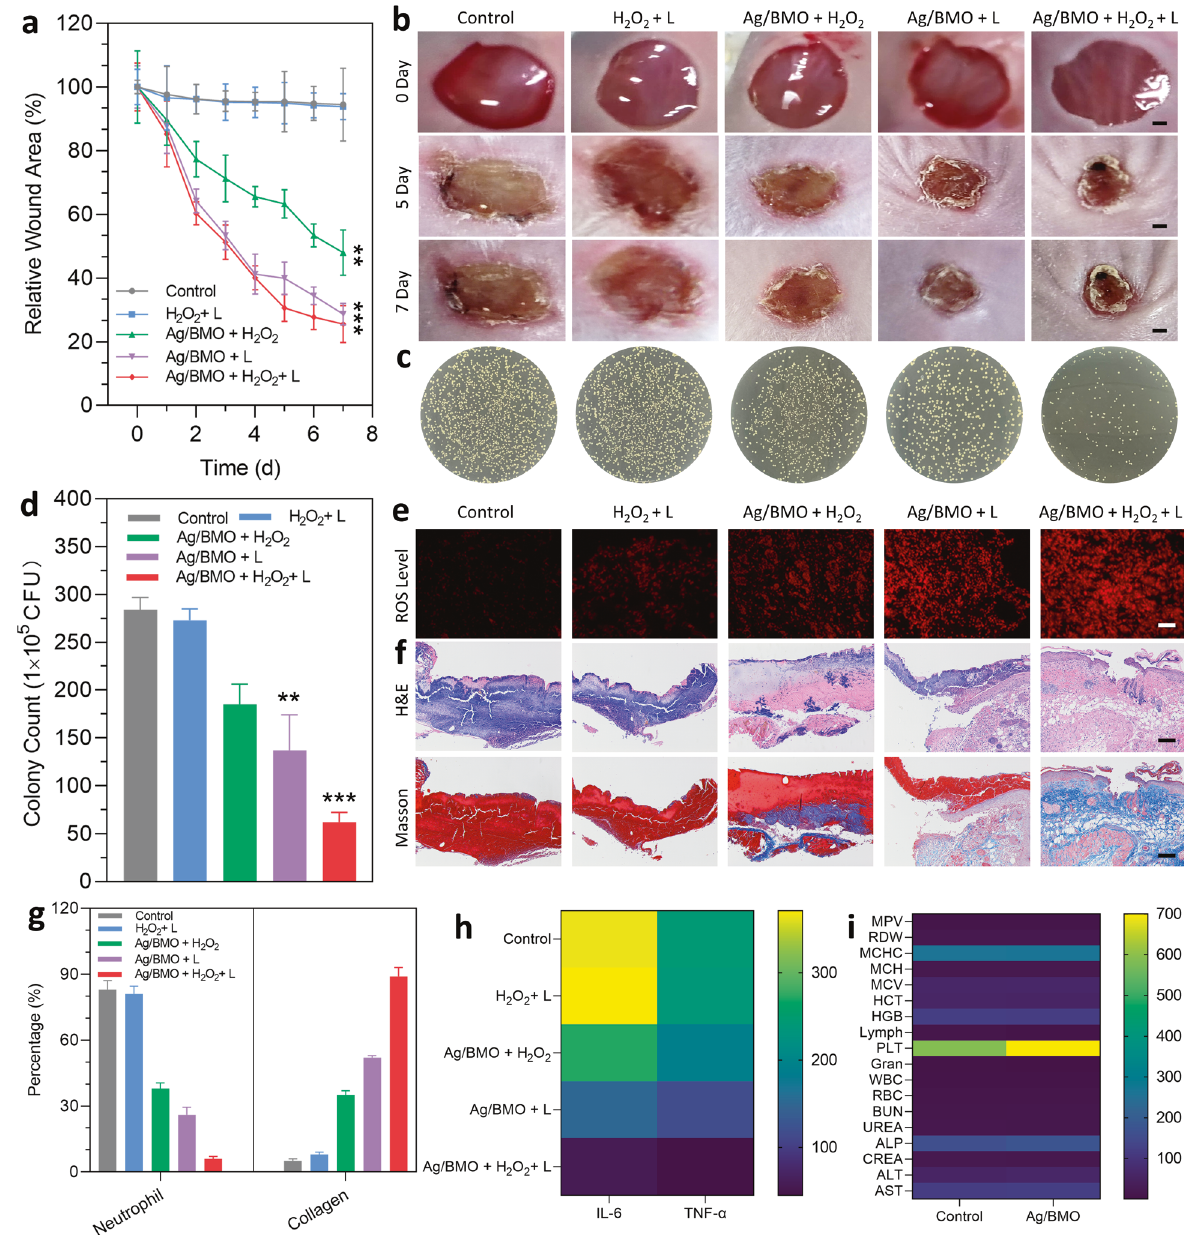
Fig. 4 In vivo MRSA-infected wound healing effect of Ag/BMO nanozyme. 1064 nm laser: 1 W cm − 2 for 10 min, H 2 O 2 : 3 mM, Ag/BMO NPs: 200 μ g mL − 1 . If not otherwise speci fi ed, all NPs were dissolved in DI water for detection. a The change of wound areas for 7 d. P -value indicates the signi fi cant difference. ** P < 0.01, *** P < 0.001. b , c Photographs of MRSA-infected wounds in various groups and the corresponding plates after treatments. Scar bar: 1 mm. d The quanti fi ed data of survival MRSA in infected wounds treated with different groups. P -value indicates the signi fi cant difference. ** P < 0.01, *** P < 0.001. e ROS level of infected wounds (more red fl uorescence indicated more ROS content). f H&E and Masson-stained tissues slices of infected wounds. g The percentage number of neutrophils and collagen index. h Levels of IL-6 and TNF- α